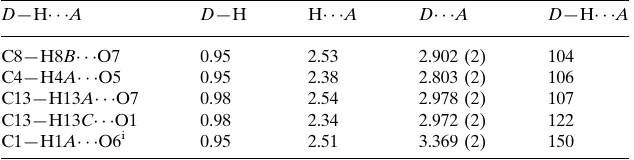
Hydrogen-bond geometry (A˚ , (cid:2)